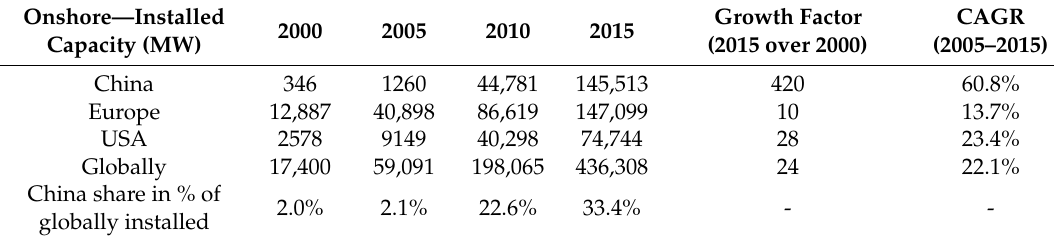
Table 6. Chinese onshore wind development growth factor and compound annual growth rate (CAGR) compared to development of onshore wind in the US, Europe, and globally (Source: Own construct using own database based on several sources, such as BTM, BTM a part of Navigant, FTI Consult, Global Wind Energy Council, EIA, [7,74,84]). Onshore—Installed Capacity